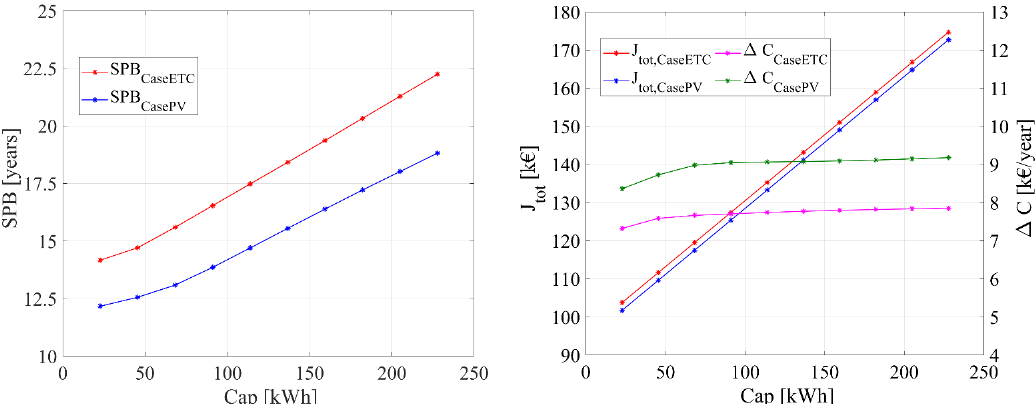
Figure 11. Parametric analysis: SPB ( left ) and capital cost and economic savings ( right ).